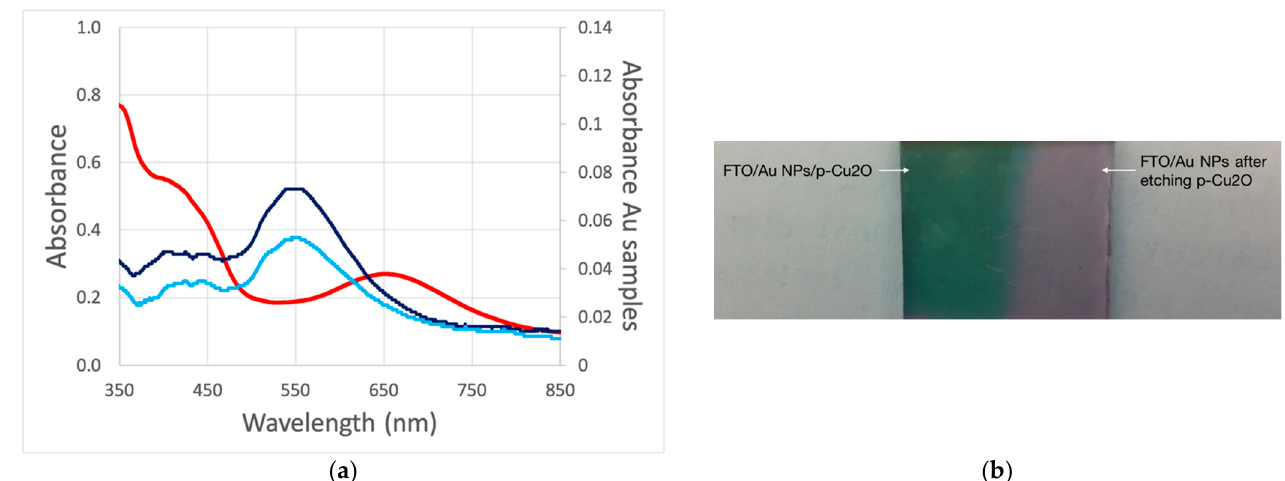
Figure 6. Optical properties of FTO/Au NPs/p-Cu 2 O film: ( a ) UV/Vis of the Au covered in Cu 2 O (red; primary axis); FTO/Au NPs fresh (dark blue; secondary axis); and FTO/Au NPs after etching with ammonia solution (light blue; secondary axis). ( b ) Photograph of FTO/Au NPs/p-Cu 2 O film with an edge etched with ammonia.